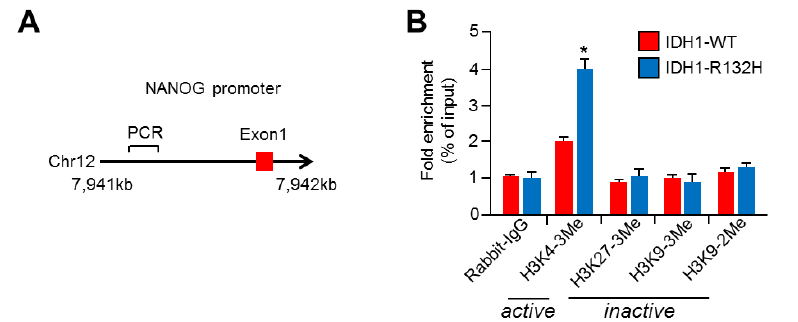
Figure 4. IDH1 R132H activates NANOG promoter with increased H3K4-3Me. ( A ) Schematic diagram of proximal region of NANOG promoter for ChIP-qPCR. Red box reveals exon 1 of NANOG gene and PCR primer sequence is provided in Materials section. ( B ) U87MG stable cell lines with IDH1-WT or IDH1 R132H expression were incubated for 24 h. Chromatin samples were incubated with antibodies as indicated. Purified DNA samples were subjected to qPCR to analyze the promoter region of NANOG gene. The values represent the mean ± SD of three independent experiments performed in duplicate; * p < 0.05. Fold changes were normalized to 1% of input sample.